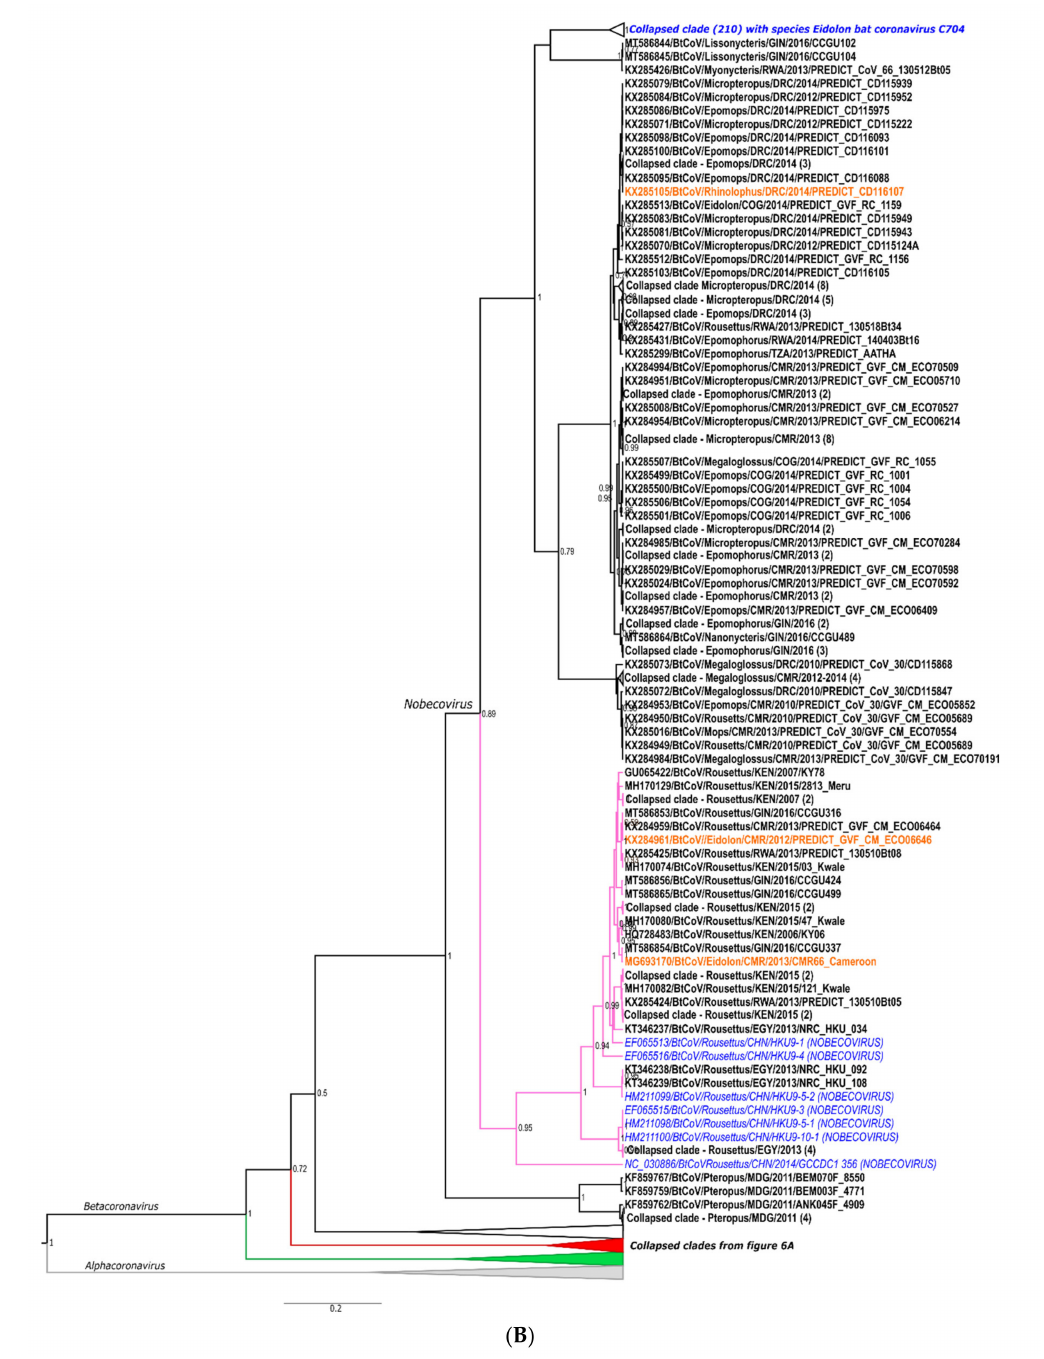
Figure 6. ( A , B ): Bayesian Betacoronavirus phylogeny of a 294-nucleotide sequence region of the RdRp gene. Shorter sequences were omitted. Clades collapsed in A are shown in B (and vice versa), and the collapsed clade of Eidolon nobecoviruses may be viewed in Figure S2). Sequences in italics indicate formally recognized species (subgenera are indicated in capital letters at the end of sequence names); sequences in bold originate in Africa; red highlights human viruses; green indicate non-bat animal hosts; blue/italics indicate formally recognized bat species; orange indicate viral detections from hosts not typically associated with a particular group of coronaviruses. All sequence names were edited to conform to the correct convention, with the modification of the unique sequence identifier listed last due to convenience. Only posterior probabilities of greater than 0.5 are indicated. No unpublished sequences were